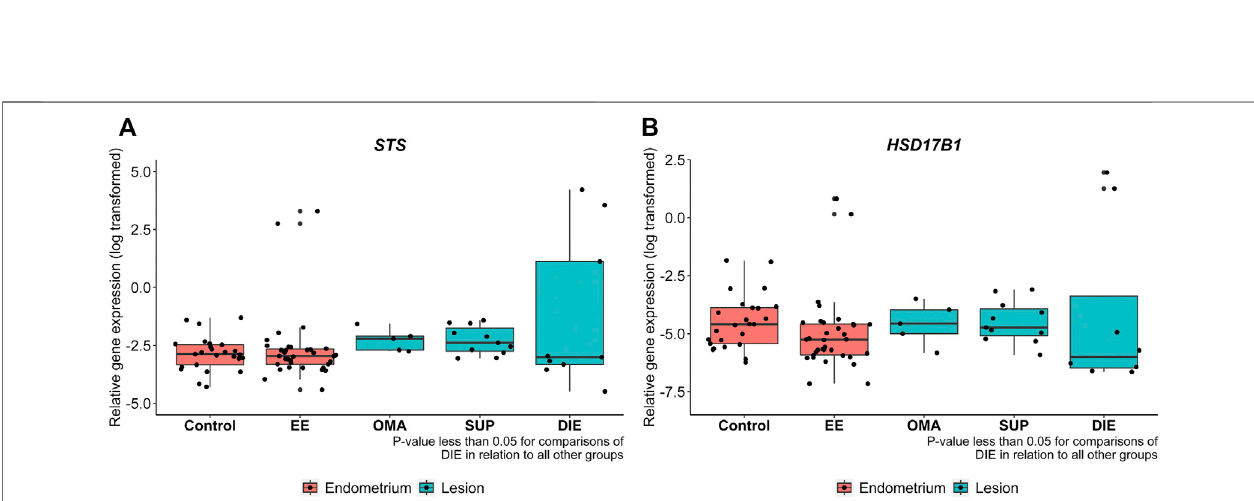
FIGURE 4 | STS (A) and HSD17B1 (B) mRNA expression in endometriotic and nonendometriosis endometrium control samples. Gene expression levels of STS andHSD17B1wereanalyzedbyqRT-PCRinendometriumfromcontrolnonendometriosispatients(control)andeutopicendometriumfromendometriosispatients(EE), ovarian (OMA), super fi cial (SUP), and deep-in fi ltrating (DIE) lesions. Relative gene expression levels were normalized by GAPDH. Bars represent the log 10 mean fold change of the normalized gene expression relative to a reference sample, and 95% CI. Statistical differences between groups are indicated by * p <